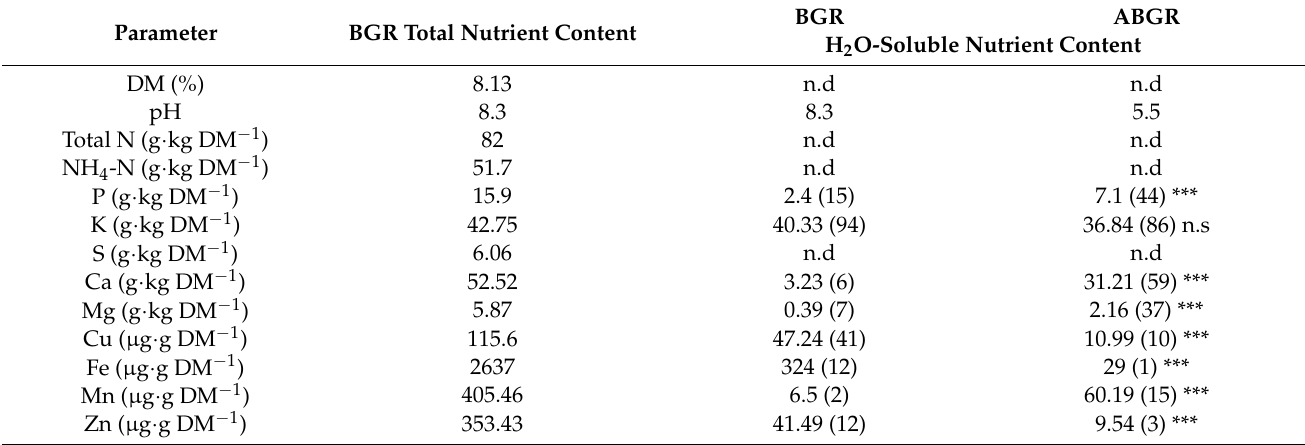
Table 2. Total and H 2 O-soluble nutrient contents of the analyzed biogas residue (BGR). Values of macronutrients are given as g · kg DM − 1 (dry matter) and micronutrients as µ g · g DM − 1 . Values in parentheses represent the percentage of H 2 O-soluble nutrients of total. Asterisks (*** p ≤ 0.001) indicate significant differences between acidified biogas residue (ABGR) and BGR. n.s, not significant; n.d, not detected. Values are the means of at least two replicates. The standard deviation is not indicated to improve the readability of the